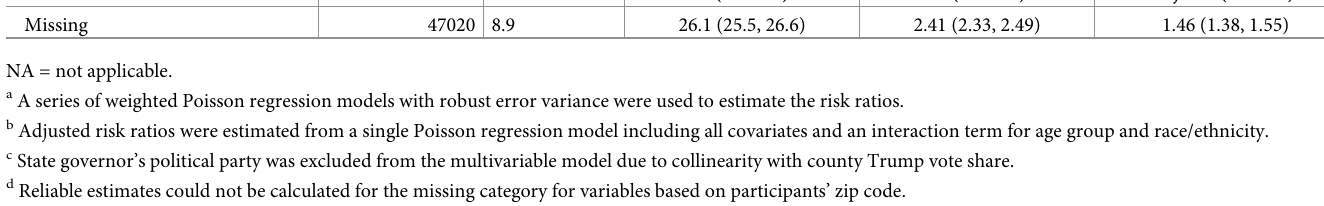
PLOS ONE | https://doi.org/10.1371/journal.pone.0260731 December21,